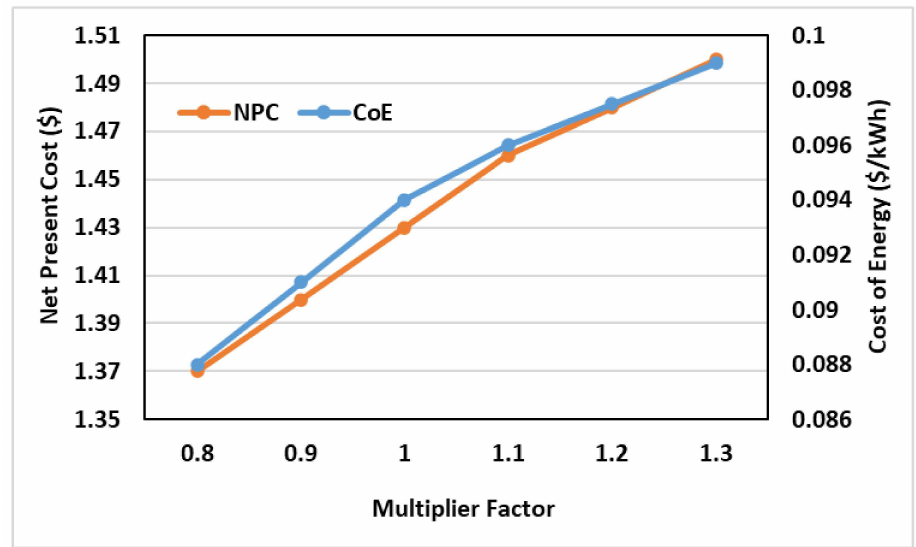
Figure 13. NPC and CoE of HRES with variation in biogas generator cost.